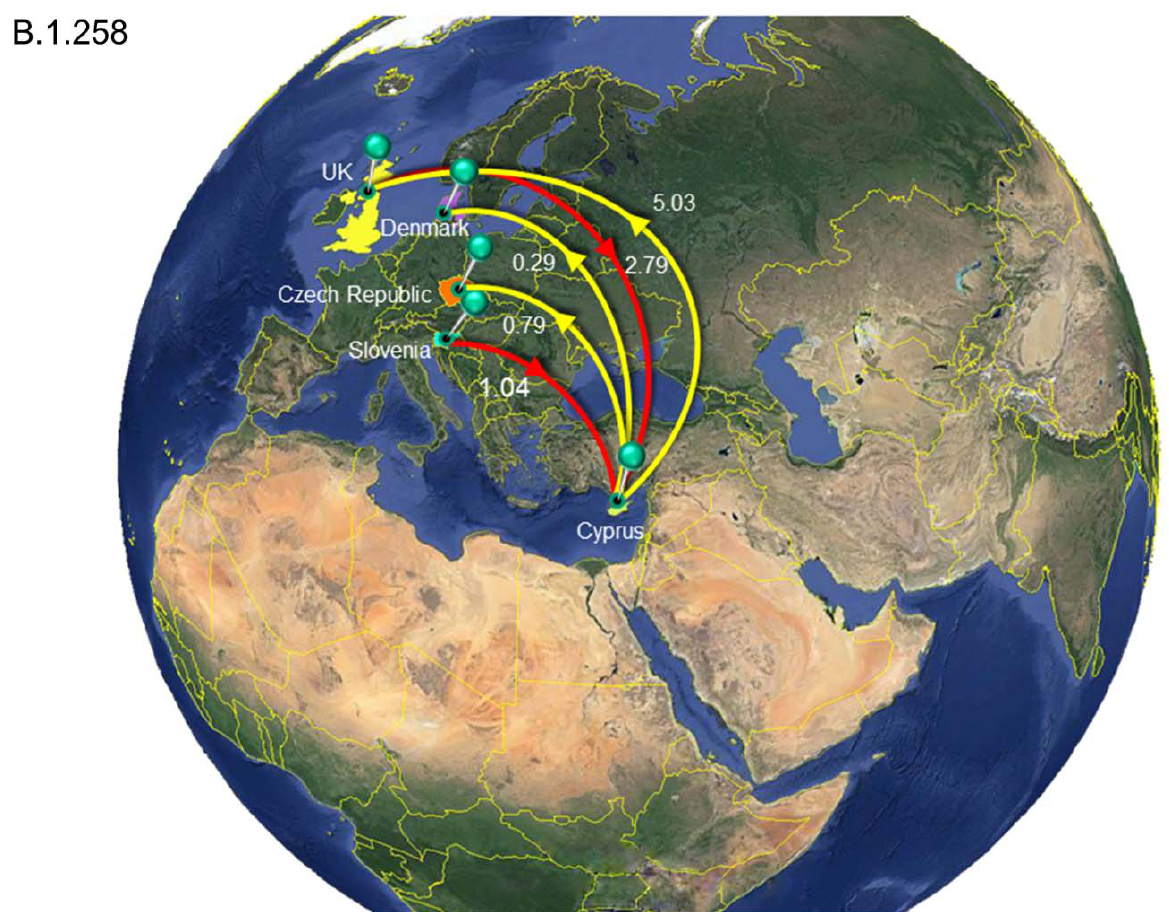
Figure 9. Map of SARS-CoV-2 B.1.258 clade group transmission between Cyprus and other countries. The geographic origins of SARS-CoV-2 B.1.258 imported into Cyprus based on the statistical phylogeographic analysis are shown as red lines, and exports from Cyprus to other countries are shown as yellow lines. Countries acting as “sources” or “sinks” for SARS-CoV-2 B.basal transmission are highlighted and labeled, and the average number of migration events is indicated. Map images courtesy of Google Earth Pro 7.3.2.5776 (14 December 2015). Global view centered on Europe. 36°16 ′ 38.78 ″ N 36°07 ′ 29.71 ″ E, Eye alt 7949.12 km. US Dept. of State Geographer, DATA SIO, NOAA, U.S. Navy, NGA, GEBCO. Image Landsat/Copernicus. 2018 © Google. https://www.google.com/earth/versions/#earth-pro (accessed on 10 April 2019).